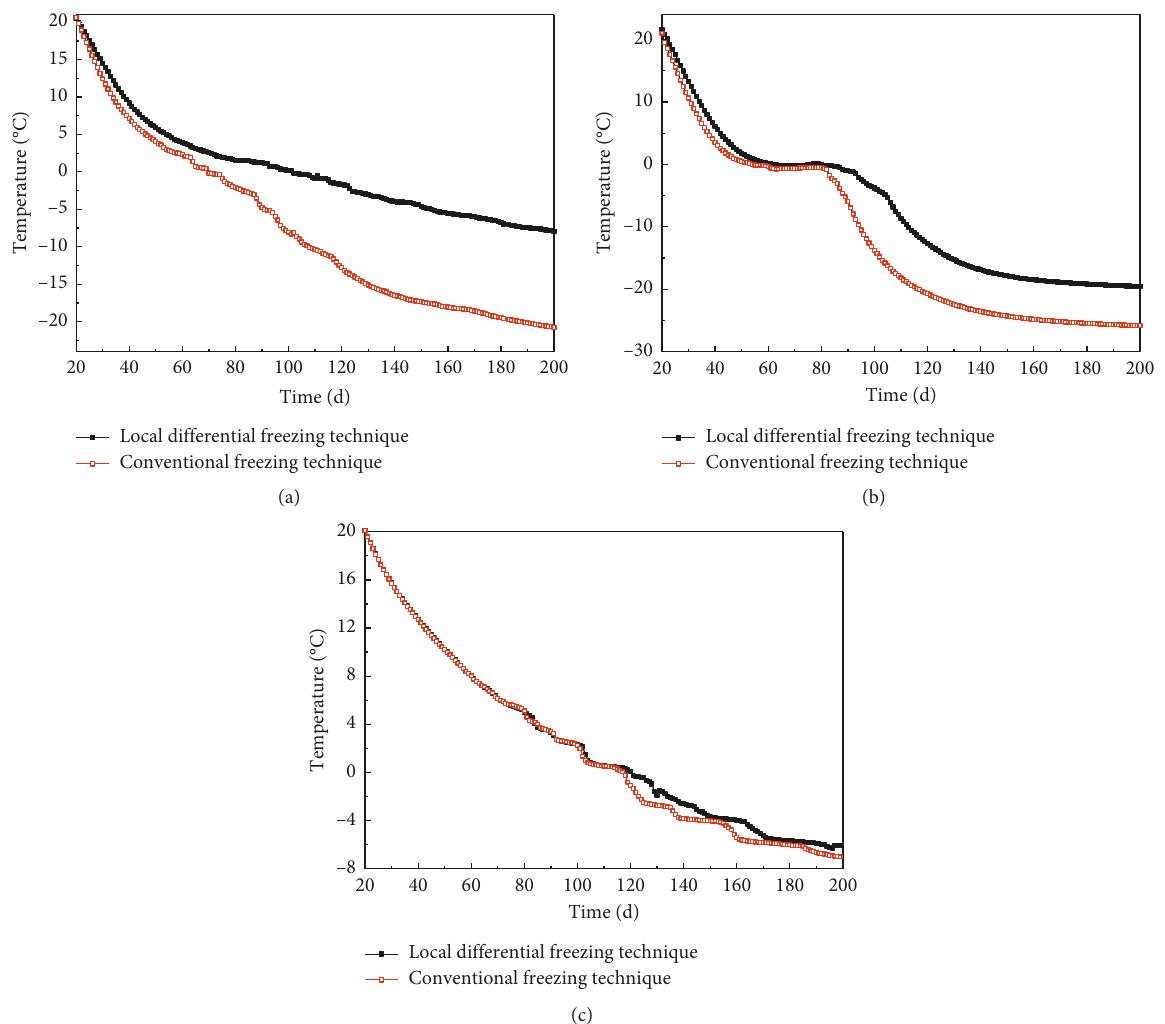
Figure 9: Variation of temperature in different regions for the conventional freezing method and local differential freezing technology (the minimum temperature of the efficient freezing and limited freezing parts of the local differential freezing pipe was − 28.6 and − 13.5 ° C, respectively). (a) Temperature curve at the measurement point C5. (b) Temperature curve at the measurement point C2. (c) Temperature curve at the measurement point